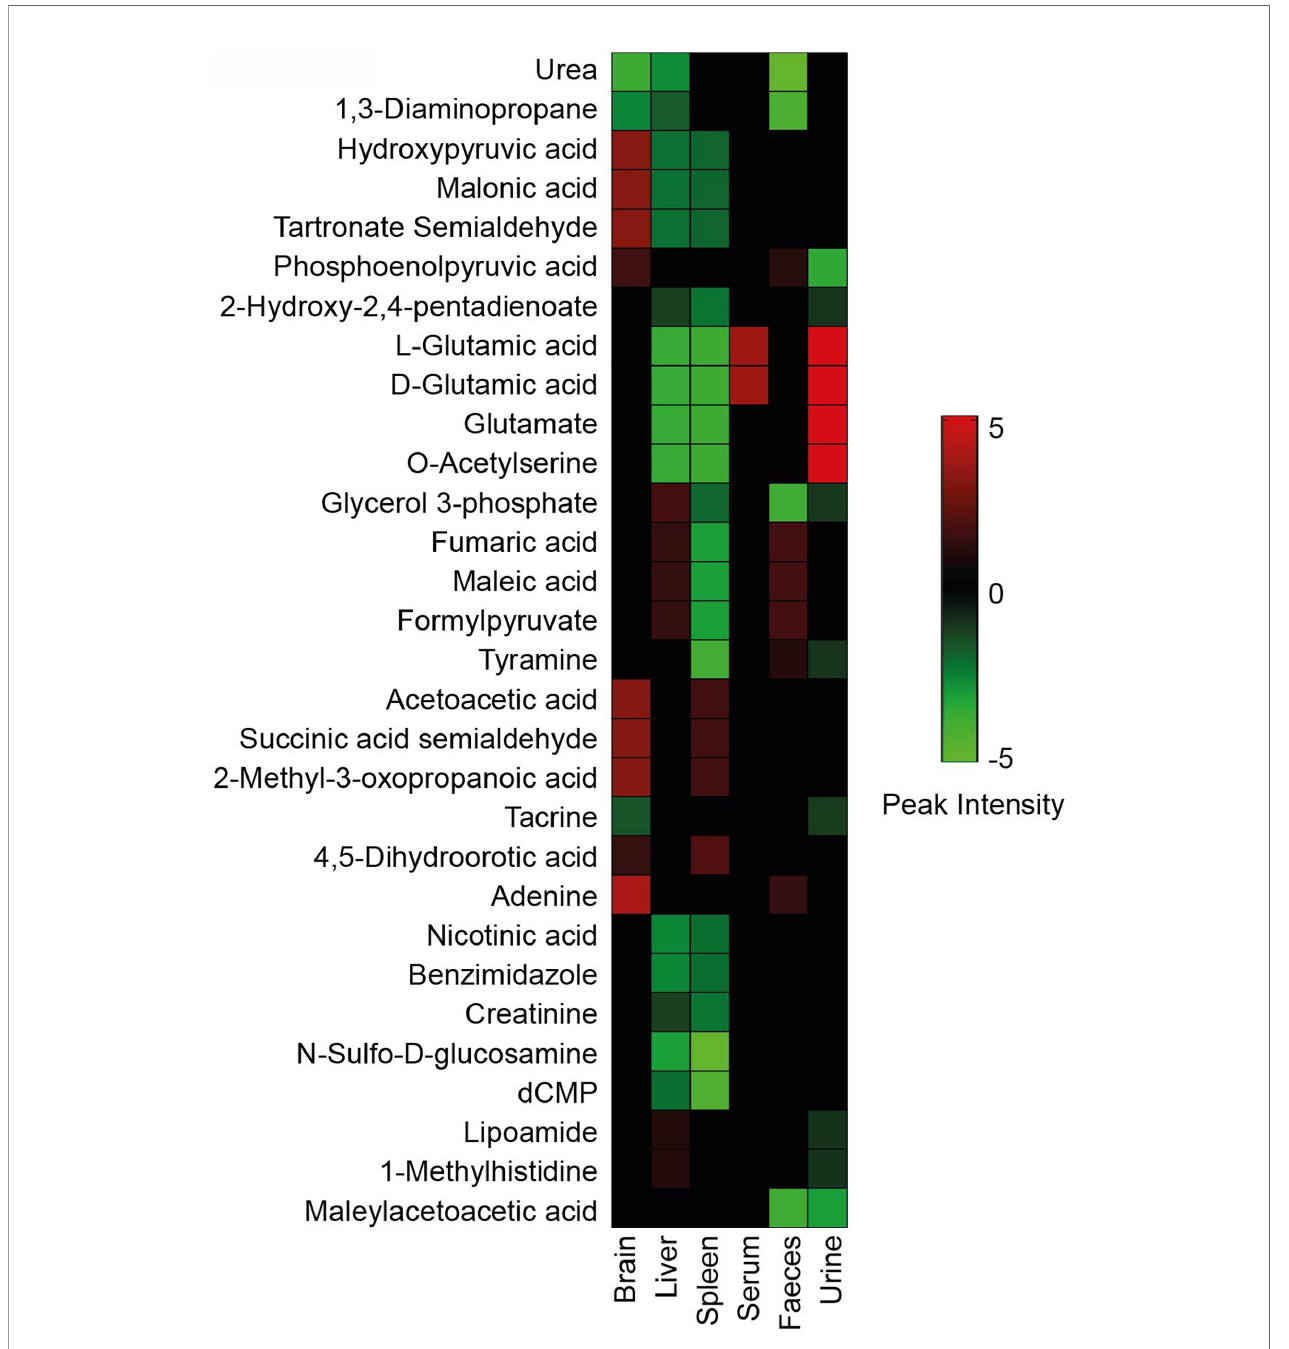
FIGURE 6 | Metabolite heatmap. Signi fi cantly identi fi ed metabolites from the control vs infected group have been compared across different sources with respect to their normalized peak intensity. The color gradient ranging from red to green represents high to low peak intensity